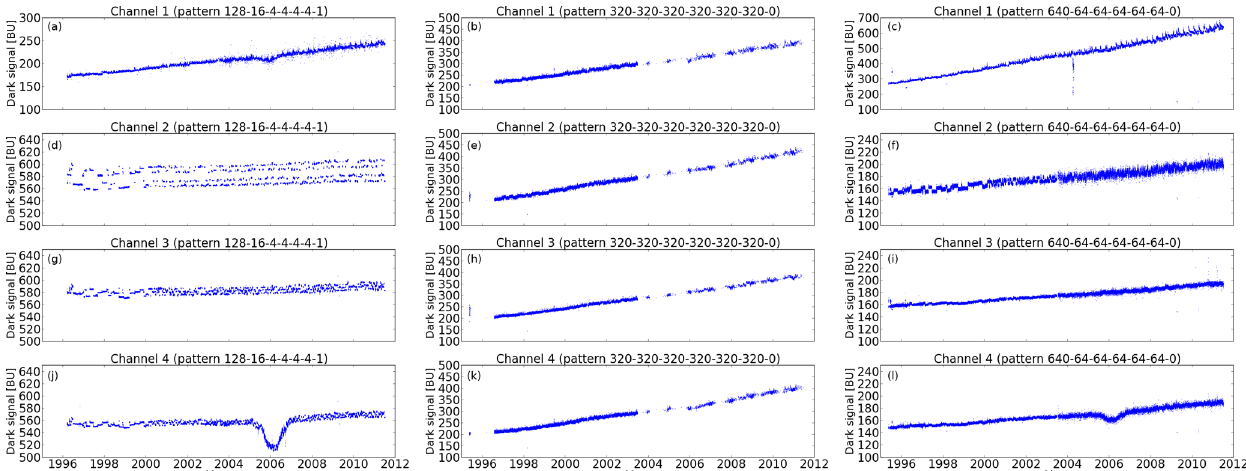
Figure 11. Dark signal in binary units (BU) as a function of time from 1995 to 2011 for three integration time patterns: normal scanning mode (12s integration time for band 1a and 1.5s for the other bands, co-adding applied for bands 2a, 2b, 3, and 4, a , d , g , j ), LED measurement mode (30s integration time for each band, b , e , h , k ), and polar view mode (60s integration time for band 1a and 6s for the other bands, c , f , i , l ). From top to bottom: band 1a, band 2b, band 3, and band 4.